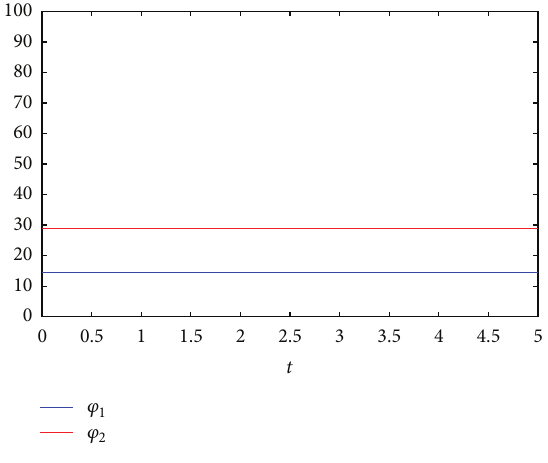
Figure 4: The energy evolution according to 𝑡